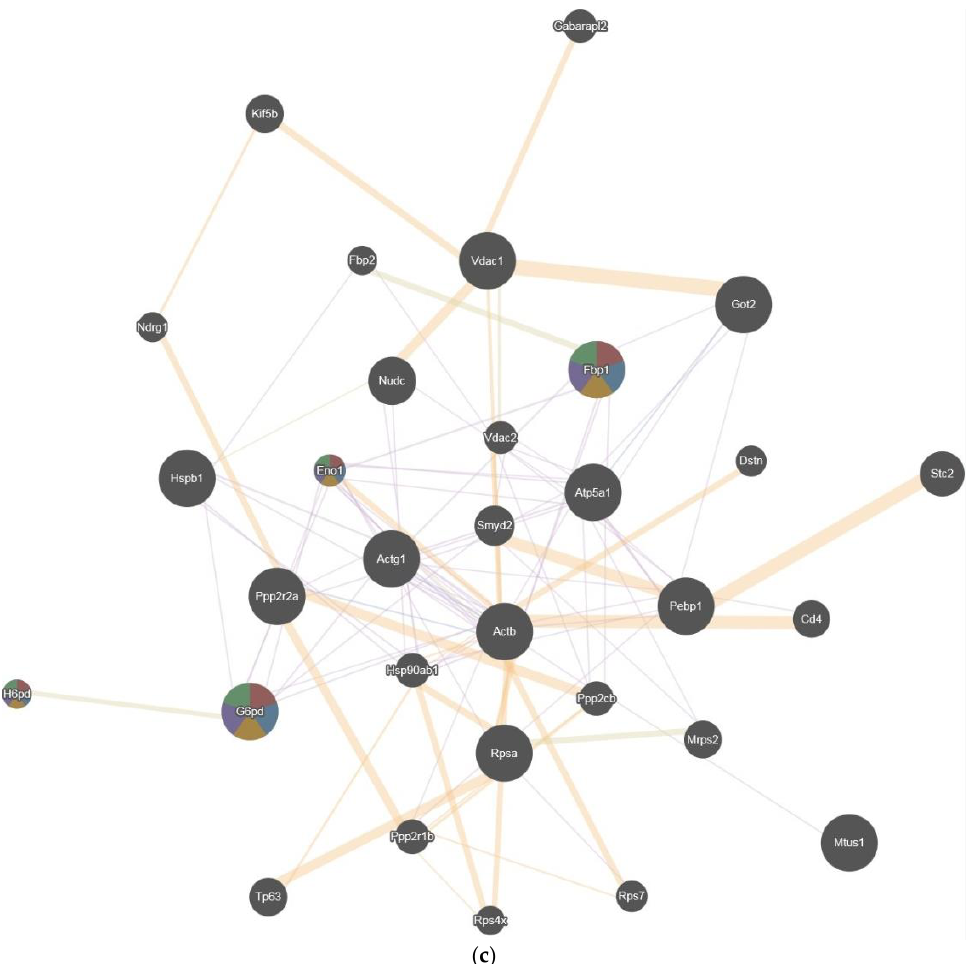
Figure 4. ( a ) GENEmania network with significantly regulated proteins involved at T0; ( b ) GENEmania network with significantly regulated proteins involved at T3; ( c ) GENEmania network with significantly regulated proteins involved at T7.